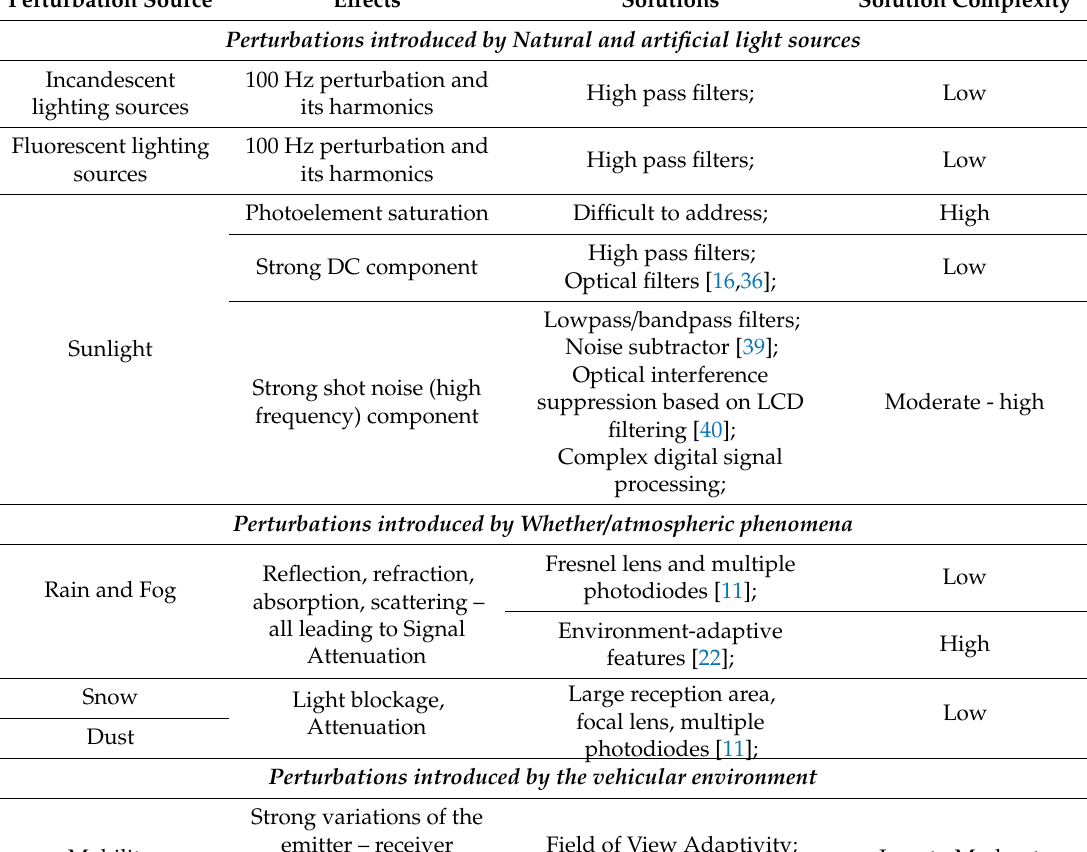
Table 1. Summary of the perturbation sources and their e ff ect on automotive VLC